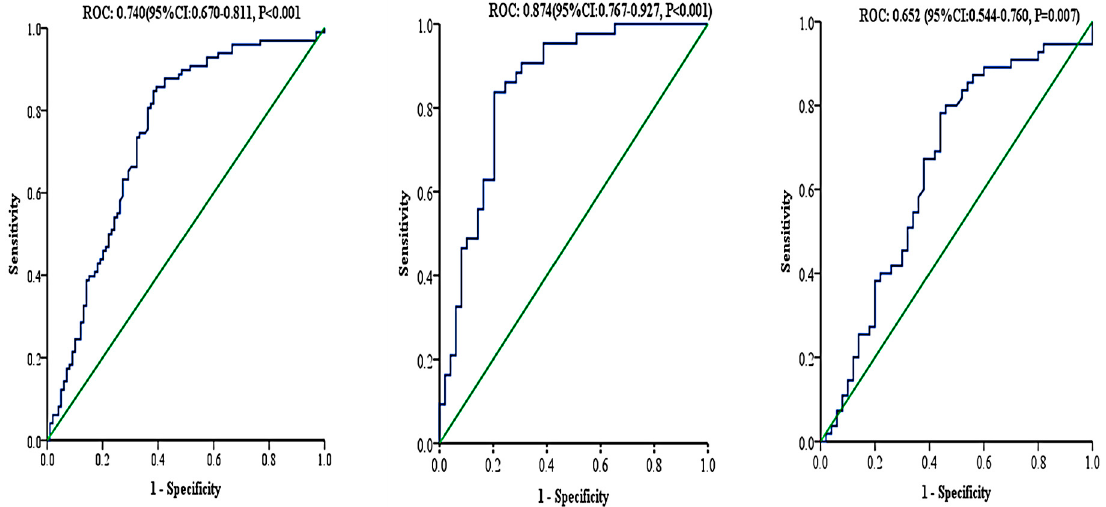
Figure 2. Receiver operational curve for TTP. All subjects ( left ), Male subjects ( center ), Female subjects ( right ).